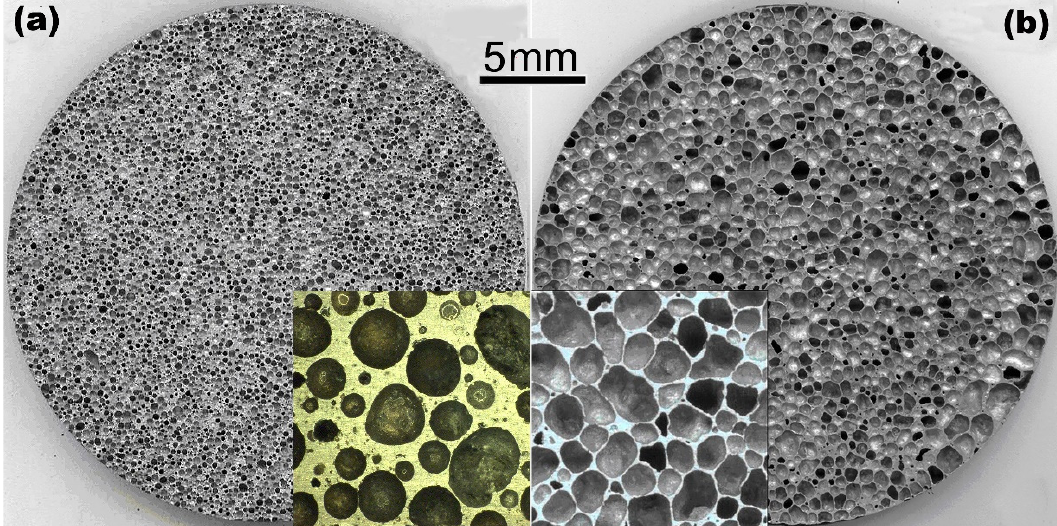
Figure 5. The cross-sectional morphologies of the pore-structures of the Al-based foams using ( a ) the MgCO 3 /Zn composite powder compared with using ( b ) TiH 2 powder as the foaming agent and the corresponding enlarged pics are the insets, respectively.